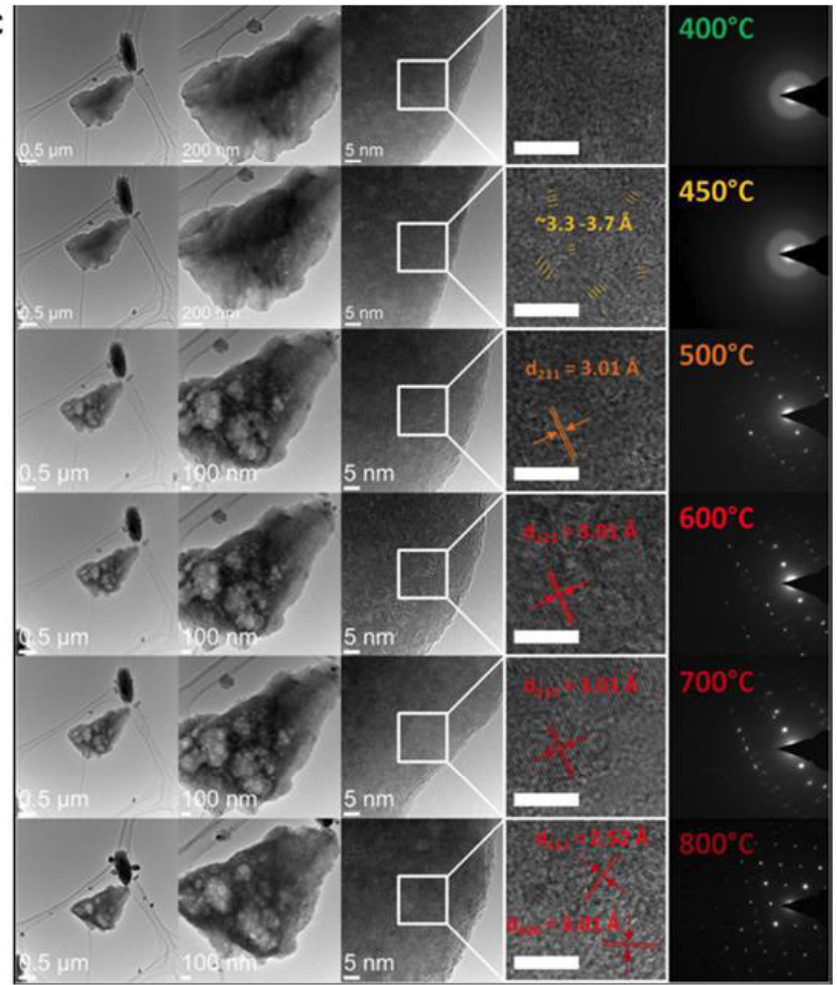
Figure 21. In-situ XRD of LiFePO 4 heated under inert atmosphere. (a) 435–700 °C. ( b ) From RT to 900 °C and then cooling to RT. ( c ) In-situ TEM of a LiFePO 4 particle heated between 400 and 800 °C. The first two columns show TEM images of the same grain; the third and fourth show HRTEM images, the fifth shows SAED patterns in the same region. Notice a slight grain rotation at 800 °C compared with 700 °C and lower temperatures, which resulted in a change of the zone axis, a different SAED pattern, and different planes visible in HRTEM images [199]; with permission of the ACS.